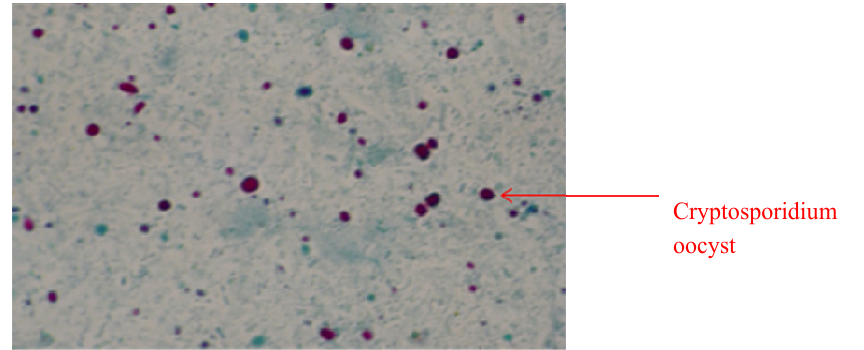
diarrhoeagenics and 72.3% HIV-negative diarrhoeagenics. Oocysts of Cryptosporidium seemed to show a spherical morphology with an indistinct internal structure (Figure 1). Figure 1. Cryptosporidium oocysts stained pinkish red (examined at 200–400×; Zeiss Axioscop epi-fluorescent microscope) and were observed as thick walled spherical structure of approximately 2–6 µm in